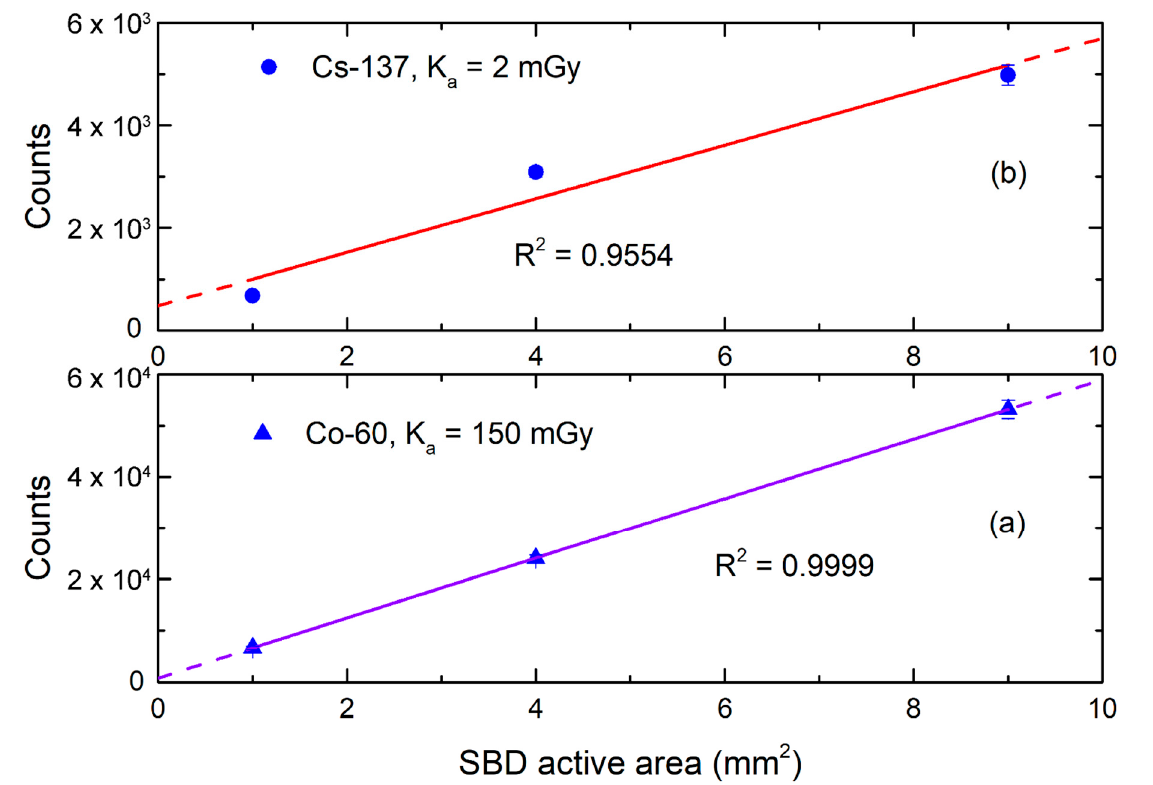
Figure 10. Response of three different 4H-SiC detector sizes (1 × 1 mm 2 , 2 × 2 mm 2 and 3 × 3 mm 2 active surface area) to gamma sources of Cs-137 ( a ) and Co-60 ( b ). Solid line in showing linear fit for three 4H-SiC detectors (active area of 1 × 1 mm 2 , 2 × 2 mm 2 and 3 × 3 mm 2 ).